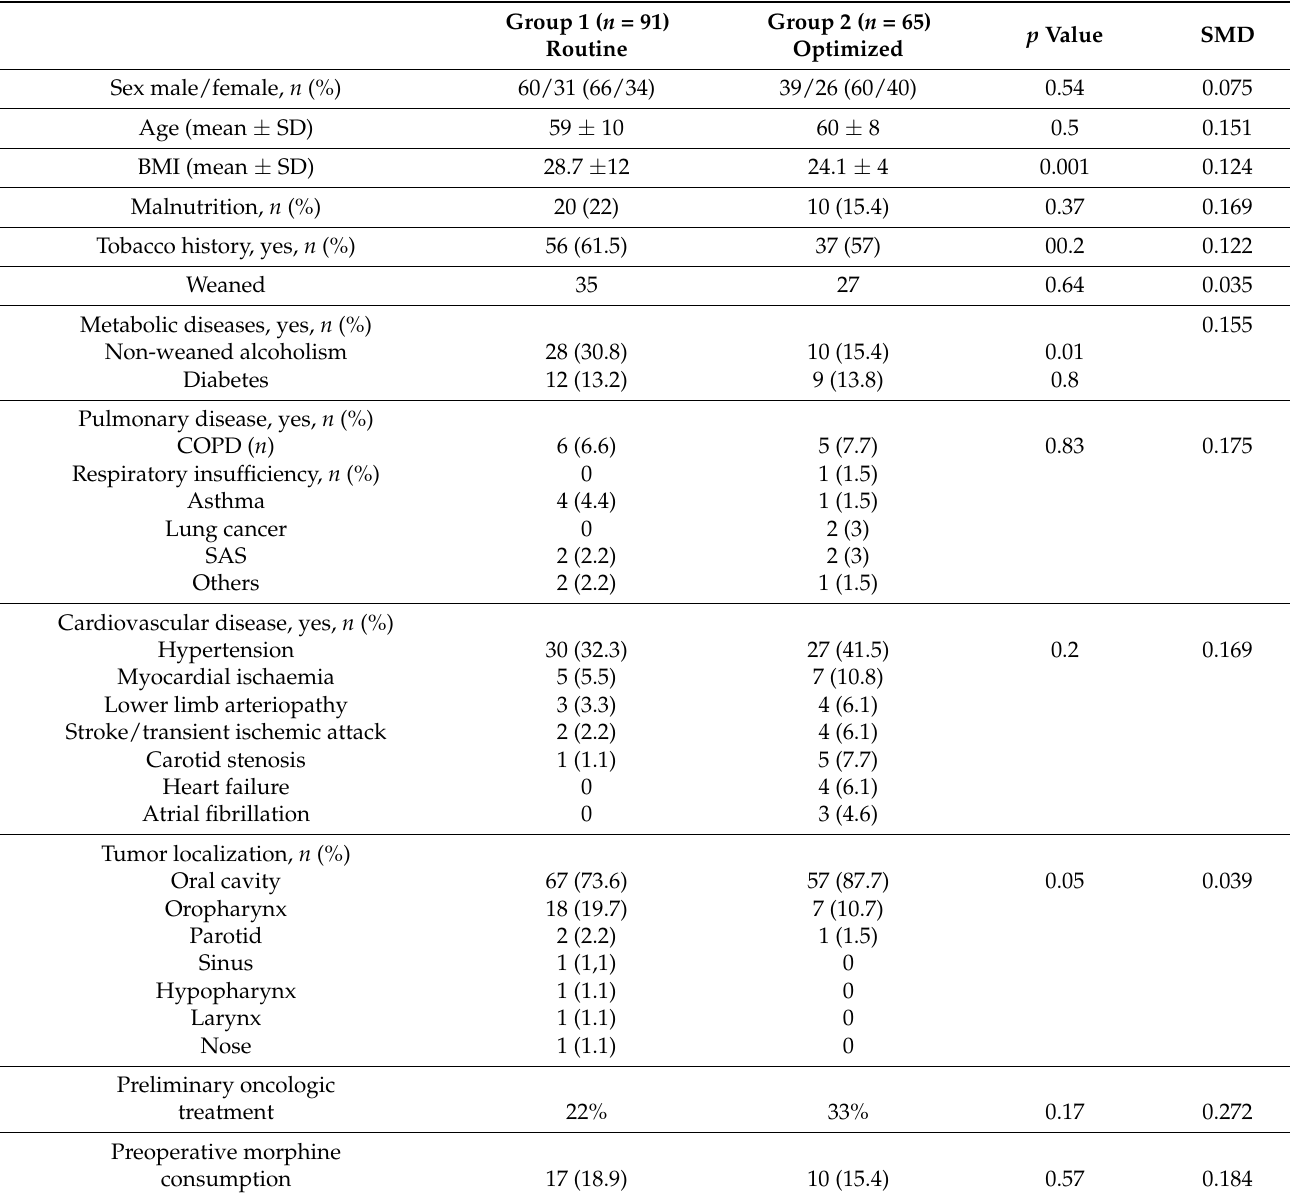
Group 2. Table 2. Demographic and preoperative